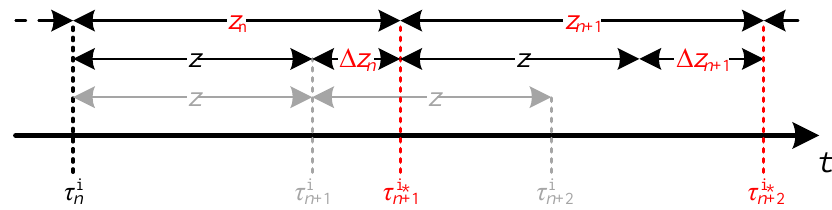
Figure 2. Proposed inspection process with dynamic inspection intervals.